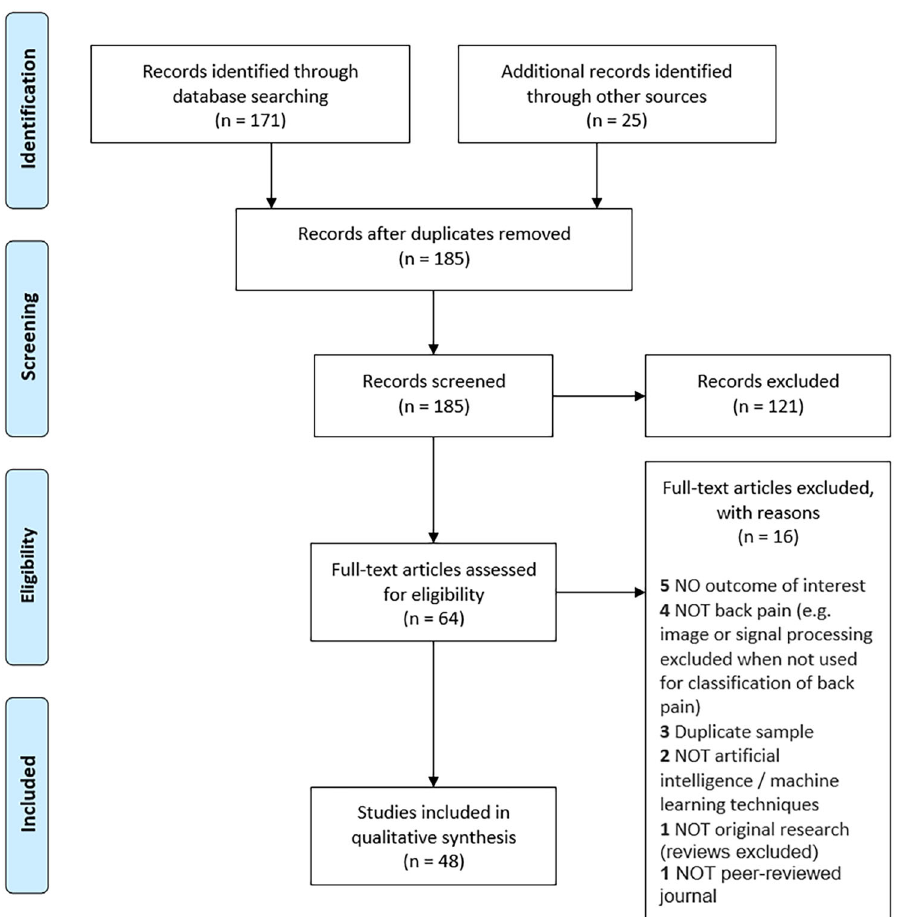
Fig. 1 Arti fi cial intelligence PRISMA diagram. Flow of the systematic review of arti fi cial intelligence/machine learning approaches in low-back pain